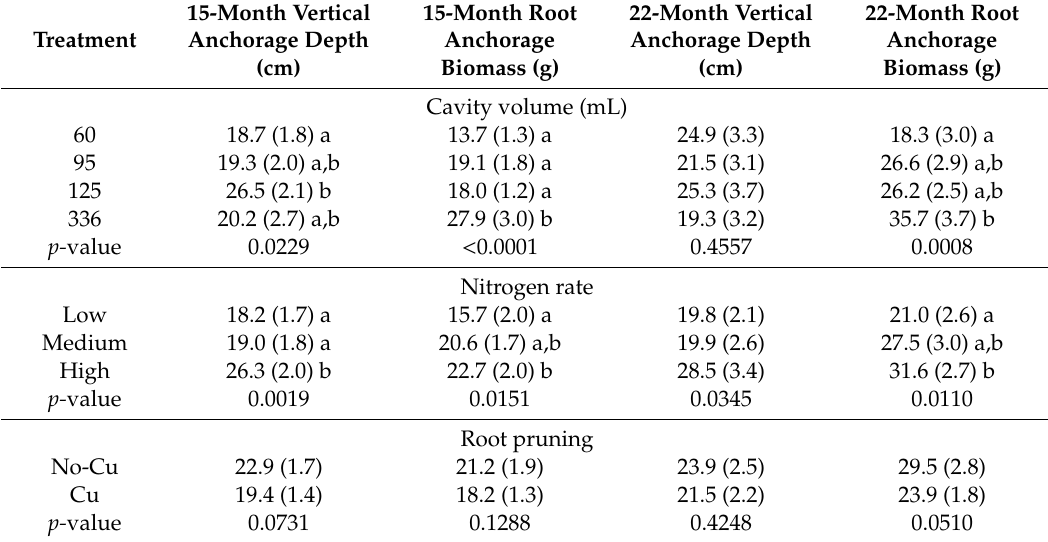
Table 5. Means (1 SE) and p -values for vertical anchorage depth and root anchorage biomass in response to nursery treatments. Seedlings were excavated 15 and 22 months after outplanting. Vertical anchorage depth was taproot depth or depth of the deepest sinker root at the point where it terminated or assumed an angle that was greater than 45 degrees from the vertical position. Root anchorage biomass was the biomass of the taproot and all sinker roots in full lengths. Within each treatment and excavation, means followed by the same letter are not significantly di ff erent at the Bonferroni-adjusted 0.05 level.